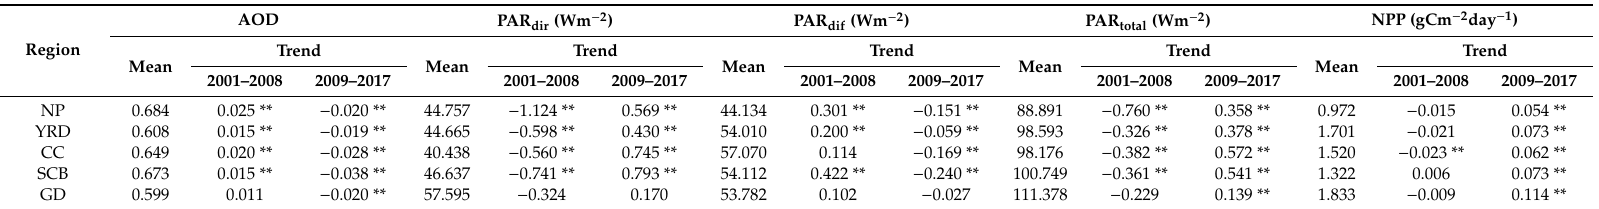
Table 2. Multi-year mean value and trends of yearly mean AOD, PAR and NPP for typical regions during 2001–2018 and 2009–2017.